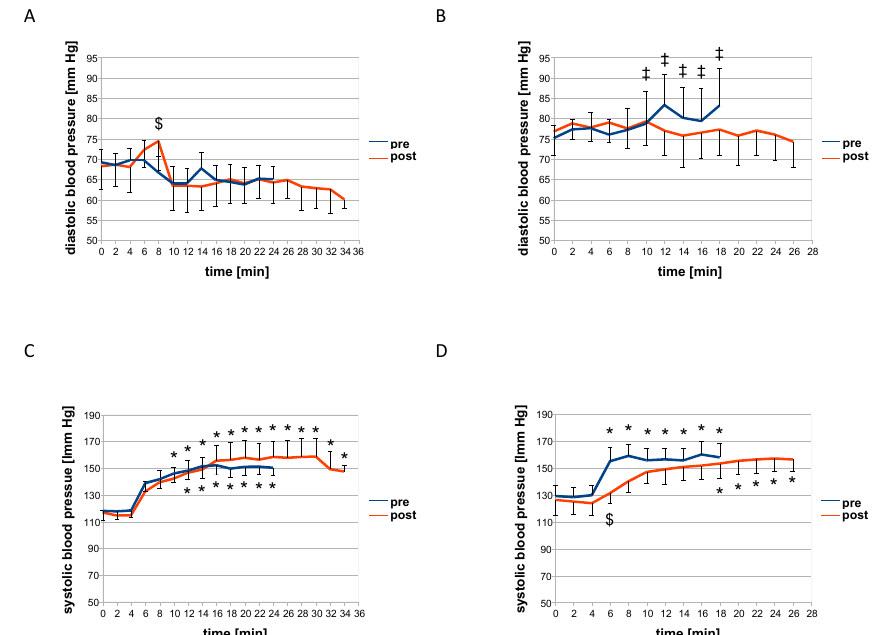
Figure 3. Temporal response of systolic and diastolic blood pressure during concentric and eccentric type of interval exercise. Line graph with whiskers indicating mean values ± SE for diastolic blood pressure ( A , B ) and systolic blood pressure ( C , D ) as measured each 2 min during the interval-type pedaling exercise before and after the eight weeks of training under the concentric ( A , C ) or eccentric ( B , D ) contraction group. *, p < 0.05 vs. 0 min. ‡, p < 0.05 vs. concentric. $ p < 0.05 vs. pre. Repeated-measures ANOVA with a post-hoc test of least significant difference.